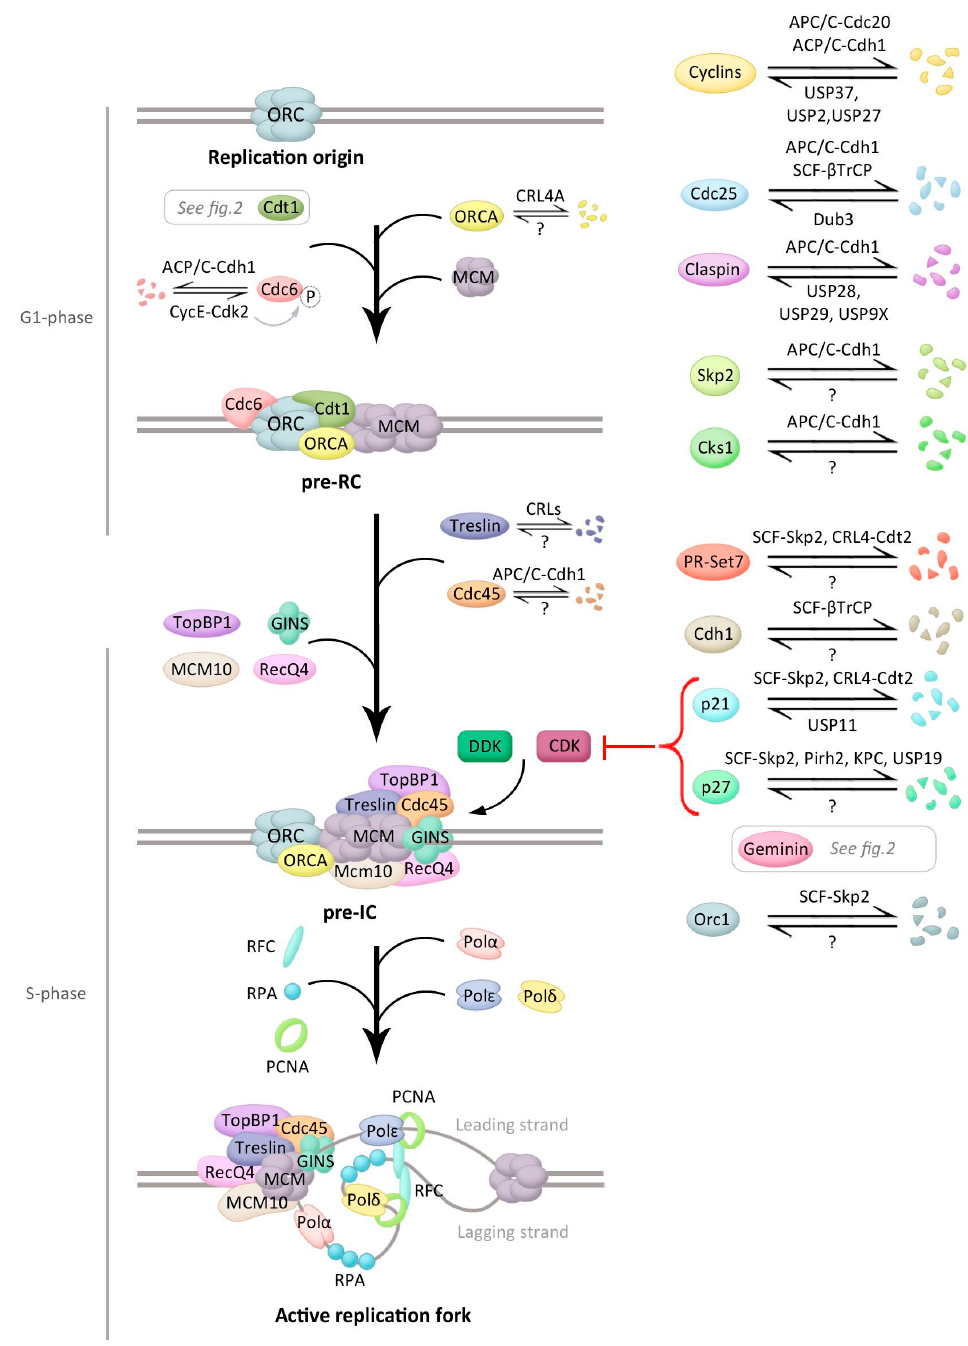
Figure 1. Main events during initiation of DNA replication and control by ubiquitination. Schematic presentation of the events occurring during DNA replication initiation (early events at the top and later at the bottom) with the main regulators in each stage. Proteins involved in this process that are modified by ubiquitin, and if known, the ubiquitin ligase(s) and/or the deubiquitinating enzyme(s) (DUB(s)) controlling this modification, are depicted. See text for details.